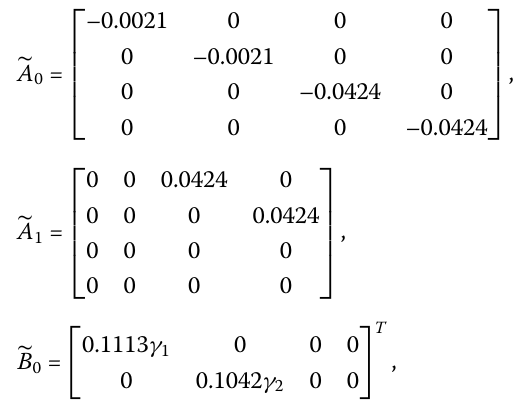
flows from Tank 3 to Tank 1 and Tank 4 to Tank 2 by gravity. The water levels for Tank 1 ( q 1 ) and Tank 2 ( q 2 ) are evaluated together as outputs. The four-tank system has received a great deal of attention, as in [13, 17, 18, 26, 46]. The four-tank system and the present controller can be written